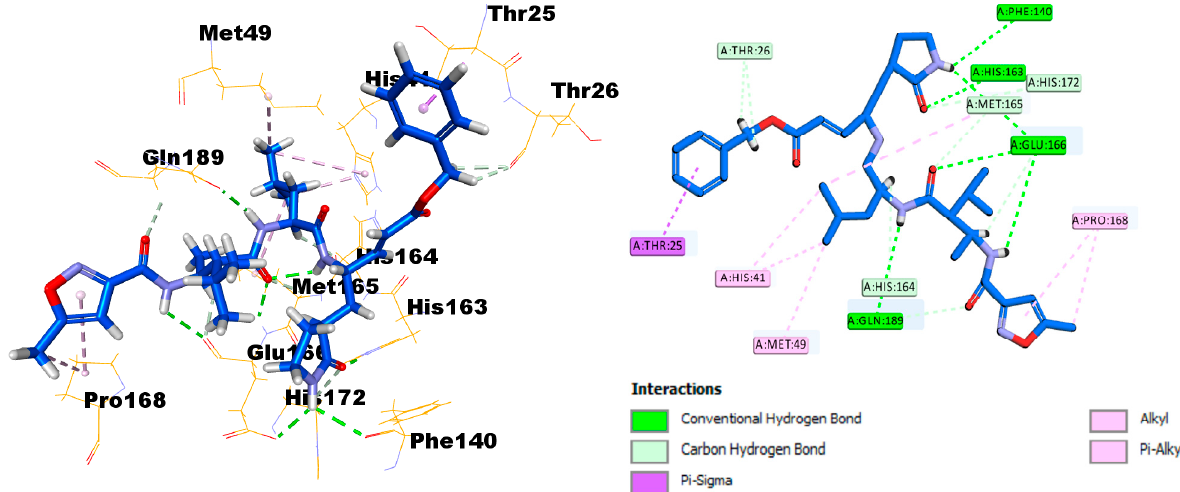
Figure 8. Docking and binding mode of ligand N3 into the active site of the SARS-CoV-2 Mpro structure (PDB ID: 6LU7).